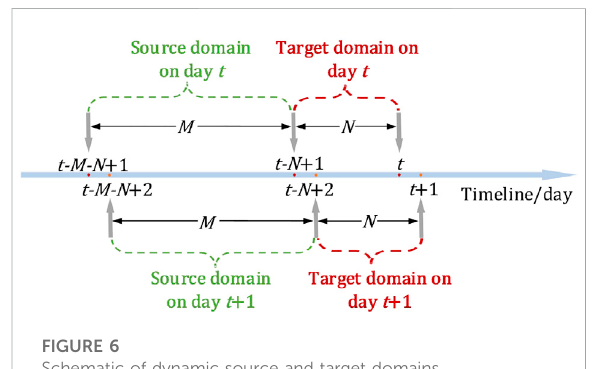
FIGURE 6 Schematic of dynamic source and target